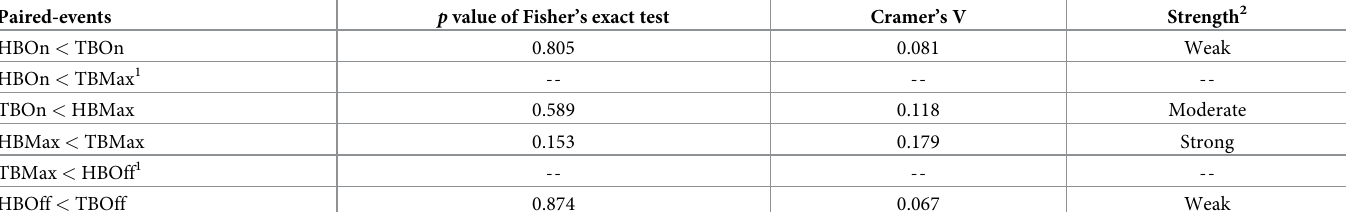
the tongue base is retracted maximally for at least 239.06ms may ensure swallowing safety to the greatest extent. The paired-event TBOn < HBMax showed > 90% adherence for most bolus types. In gen- eral, tongue base retraction commences before maximum hyoid bone excursion is reached. However, for a challenging bolus type like 10mL x thick , maximum hyoid bone excursion may be achieved early in some subjects. This is in line with the findings suggested by Nagy and col- leagues [23], which stated that velocity of hyoid bone movement increases with bolus consis- tency in non-dysphagic subjects. The paired-events HBMax < TBMax and HBOff < TBOff have relatively low levels of adherence. Individual variability is allowed in these event sequences without compromising swallowing safety. Table 5. Results of Fisher’s exact and Cramer’s V tests on the association between bolus type and adherence to the anticipated sequence of paired-events.